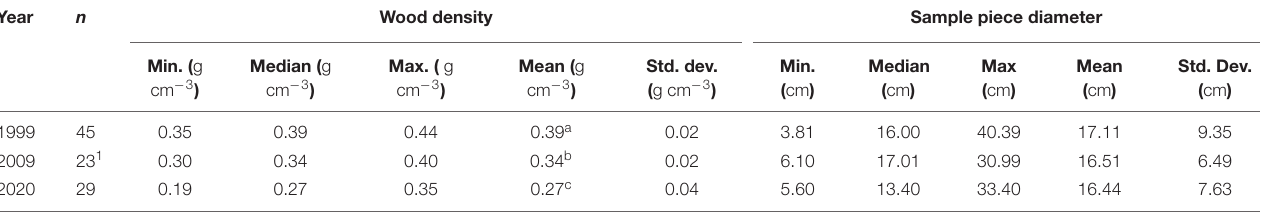
TABLE 2 | Wood density and piece diameter summary statistics for samples collected at Yr1, Yr11, and Yr22. Wood density